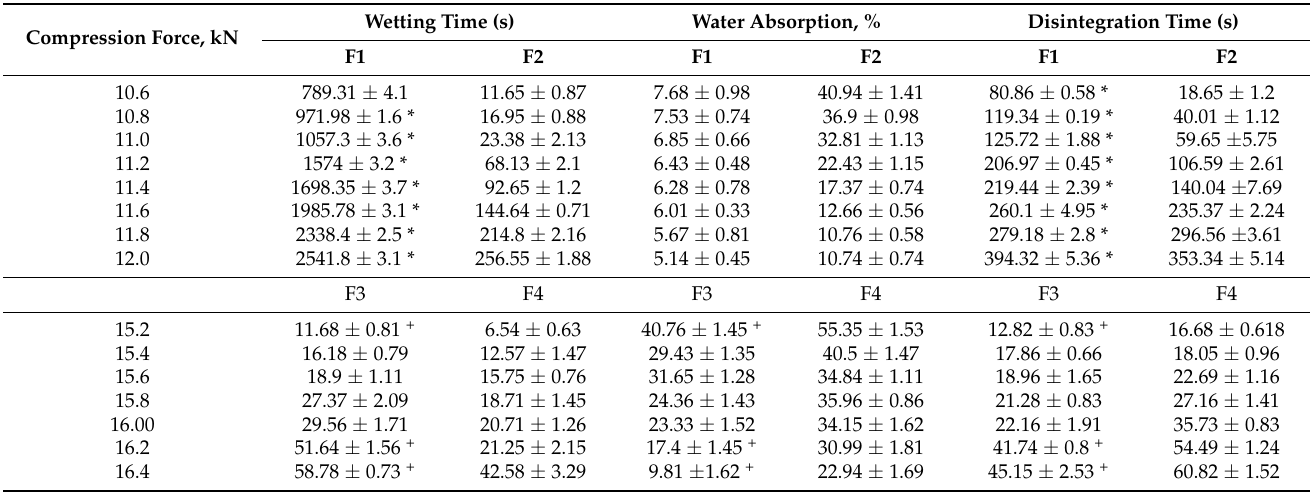
Table 5. Wetting time, water absorption, and disintegration time of meloxicam tablets of formulations F1, F2, F3, and F4. Compression Force,